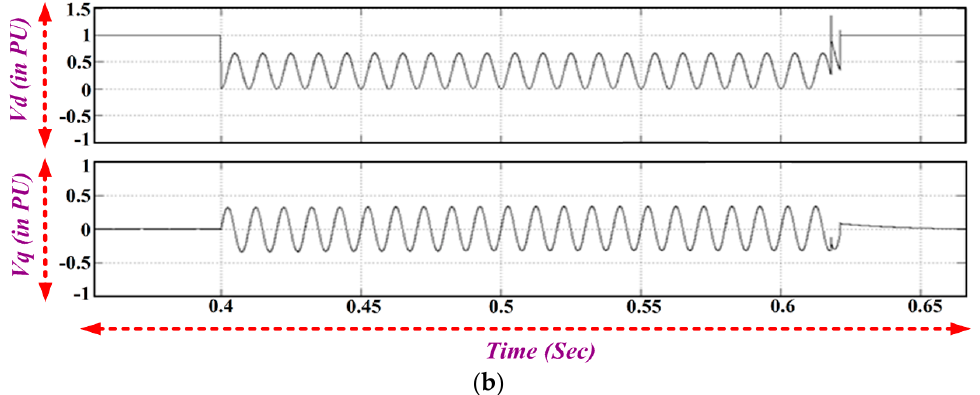
Figure 21. ( a ) Frequency and Phase Angle Variation during a Line-Line ground LLG Fault; ( b ) q- axis and d- axis Voltage Magnitude during a LLG Fault.